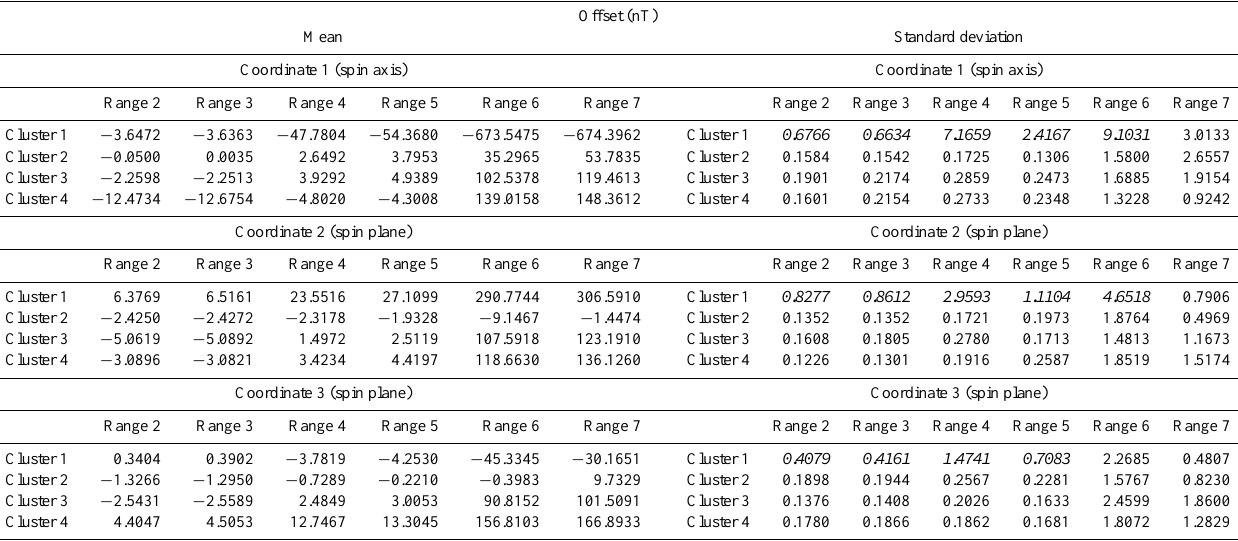
Table 2. Mean and standard deviation of the offsets ( O i ) for the mission segment February 2001 to February 2012 for each coordinate in every range on all spacecraft. Standard deviations for ranges that are at least twice as large as those for all the other spacecraft in that range are highlighted in italic.